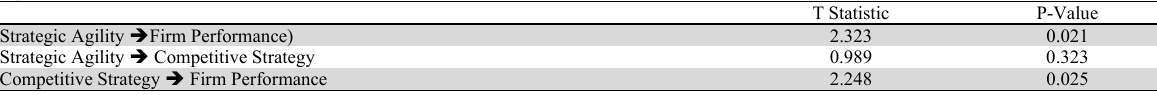
Hypothesis Test